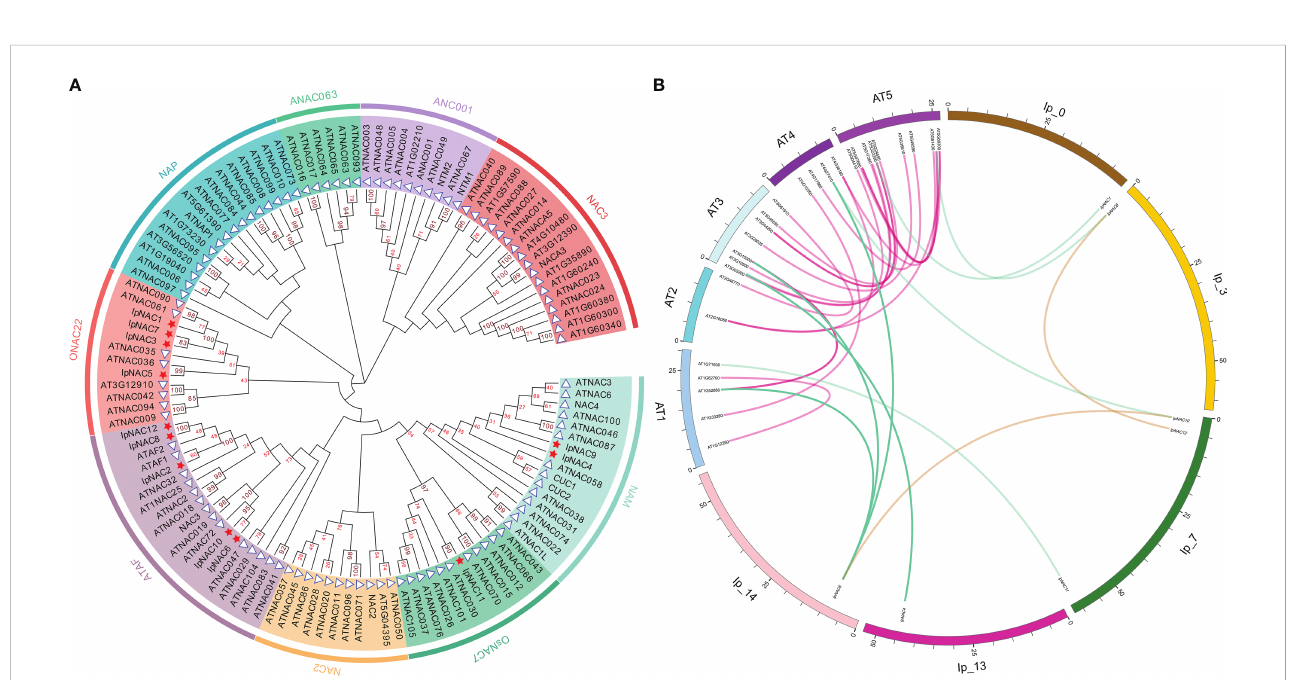
FIGURE 2 Comparative analysis of Ipomoea pes-caprae IpNACs and Arabidopsis ANAC genes. (A) Phylogenetic tree of IpNAC and ANAC proteins. The full-length amino acid sequences of the IpNAC proteins were used to construct the phylogenetic tree with MEGA X through 100 bootstrap tests and the Poisson model method. The number at the node indicates the bootstrap value. The nine subfamilies, namely ONAC22, NAP, ANAC063, ANAC001, NAC3, NAM, OsNAC7, NAC2, and ATAF, were set in different colors as the background. IpNACs are represented by red pentagons, and ANACs are represented by blue triangles. (AtNAC=ANAC). (B) Collinearity analysis of NAC genes in I pes-caprae and Arabidopsis . The chromosomes of I pes-caprae and Arabidopsis are expressed in different colors, and the positions of IpNAC and ANAC genes in chromosomes are marked. The purple curve represents the collinear region of ANAC genes, the brown curve represents the collinear region of IpNAC genes, and the blue curve represents the collinear region of ANACs and IpNACs